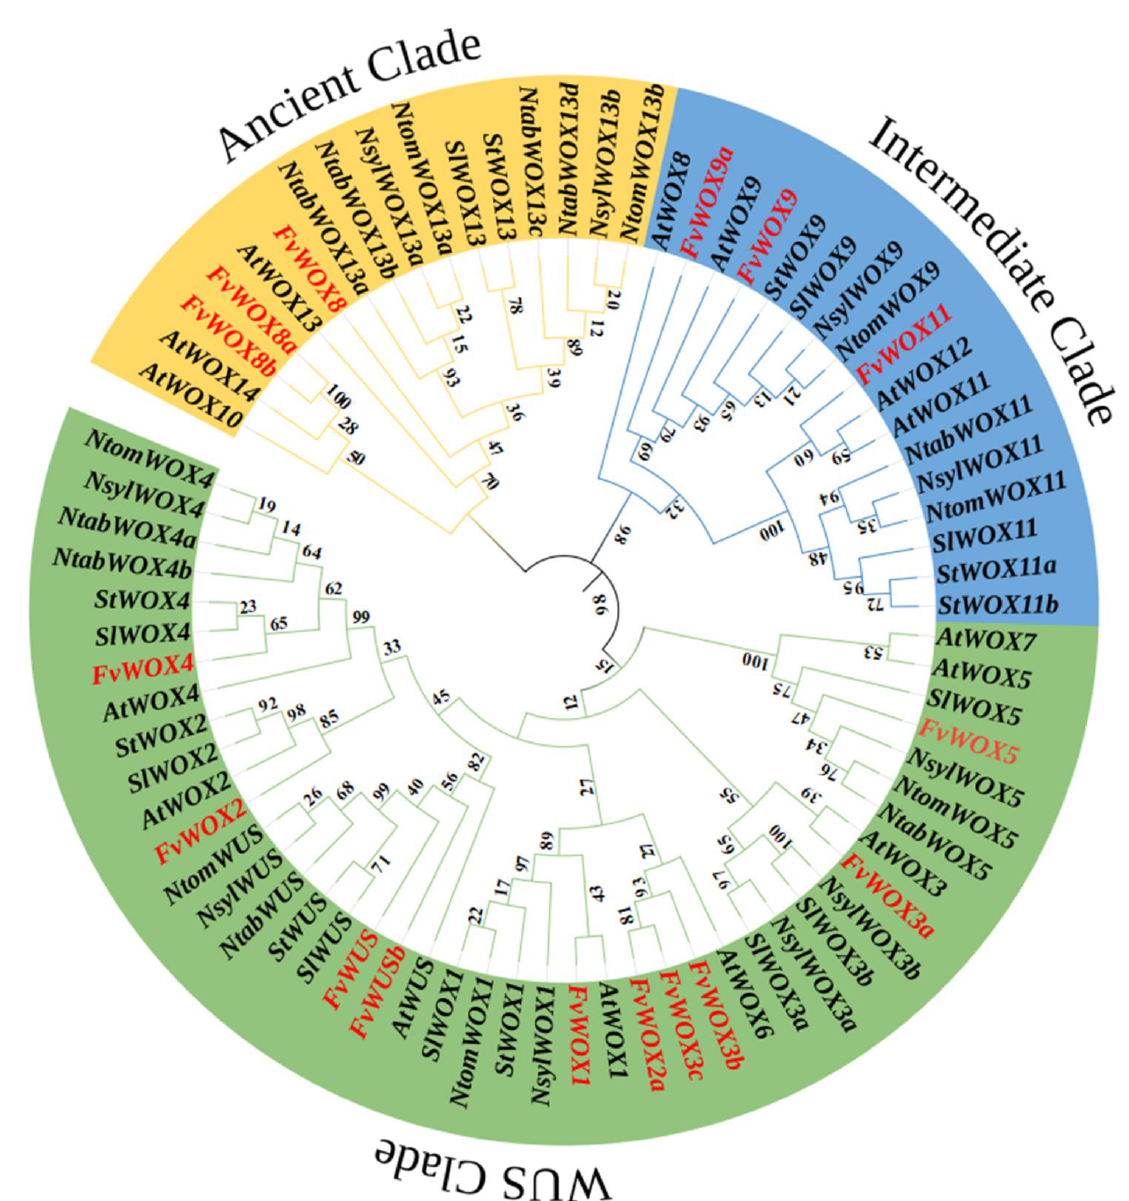
Figure 2. Phylogenetic analysis of WOX homologs in different species. All WOX proteins were divided into 3 clades (ancient, WUS, and intermediate), represented by clusters in different colors. The evolutionary history was inferred by the Maximum Likelihood method using MEGA7 software with 1000 bootstrap replicates. Fv, Fragaria vesca ; At, Arabidopsis ; St, Solanum tuberosum ; Sl, Solanum lycopersicum ; Ntab, Nicotiana tabacum ; Ntom, Nicotiana tomentosiformis ; Nsyl, Nicotiana sylvestris . WOX proteins of Fragaria vesca are marked in red font.